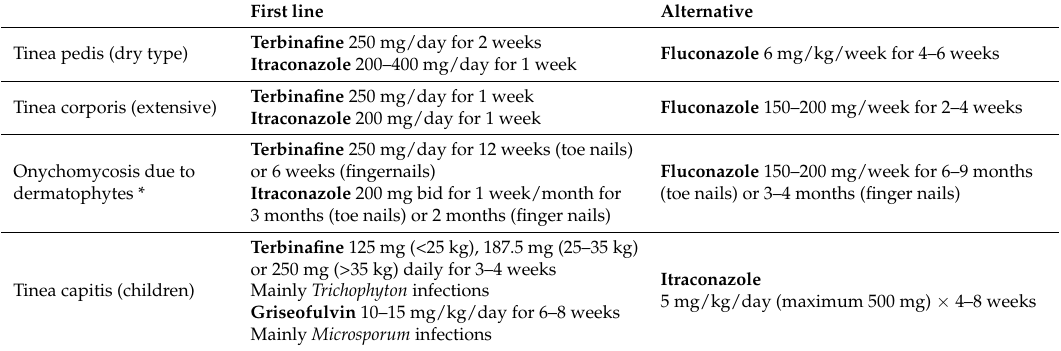
Table 1. Systemic treatment for dermatophyte infections